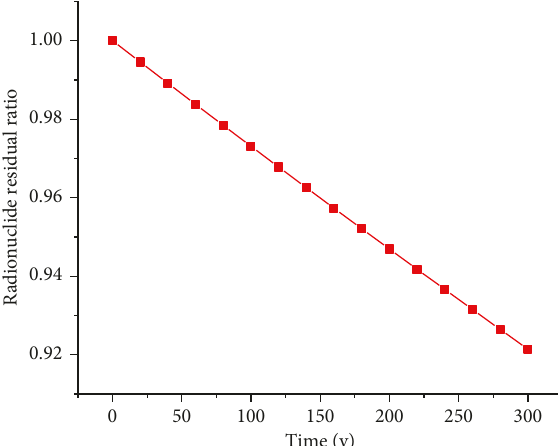
Figure 7: Radionuclide residual ratio change with time with lower limit values of parameters.